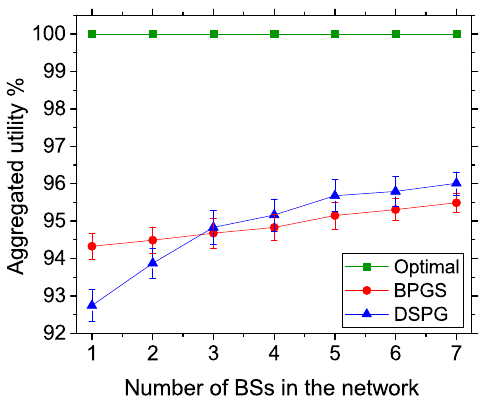
Figure 11. Estimation of aggregated utility for different numbers of